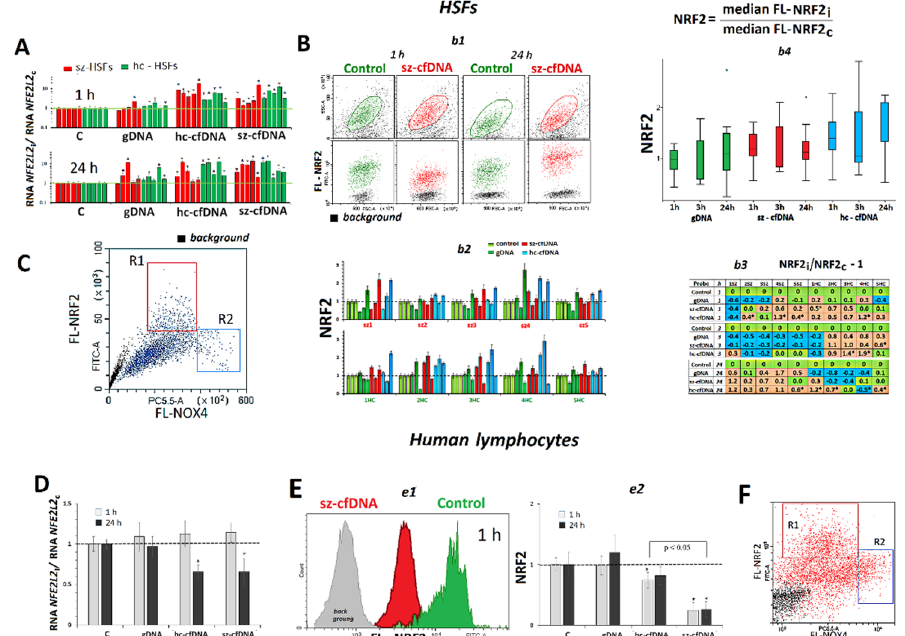
Figure 3. The influence of the DNA samples (50 ng/mL) on the expression of NFE2L2 gene in HSFs and lymphocytes. ( A ). Change of the RNA NFE2L2 in HSFs in the presence of DNA samples (50 ng/mL). Average values for three measurements and standard deviation are given. The cultivation time and the DNA samples are indicated on the graph. (*) The response to cfDNA differs from the control HSFs ( p < 0.01). ( B ). b1 —The most typical examples of the NRF2 assay with FCA in HSFs. The data from the device are given for sz-HSF1. b2 —Index NRF2: the values of the medians of FL-NRF2i, normalized to the control signal value. Average values for three measurements and standard deviation are given. b3 —Analysis of relative changes in NRF2 levels in the presence of DNA samples compared to control. Green color—no significant differences with the control ( p > 0.01), red—increased RNA content in the presence of the DNA probe ( p < 0.01) and blue— decreased RNA content ( p < 0.01). ( C ). FCA. Sz-HSF4 staining with two types of antibodies with different labels: NRF2 (FITC) and NOX4 (PC5.5). ( D ). Change of the RNA NFE2L2 in the PBL in the presence of DNA samples (50 ng/mL). Average values for four lymphocyte samples and standard deviation are given. ( E ). e1 —The most typical examples of NRF2 assay with FCA in lymphocytes. e2 —Changes in the NRF2 index in sample of lymphocytes (n = 4). ( F ) The amounts of NOX4 and NRF2 proteins in